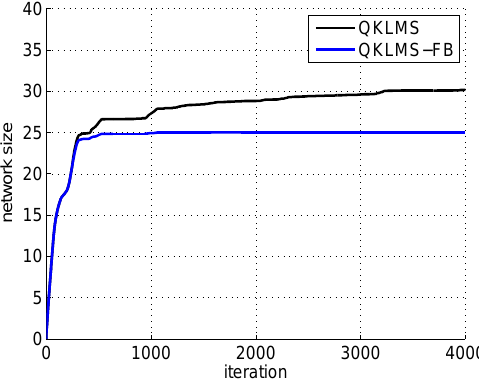
Figure 5. The network size growth curves of the QKLMS and QKLMS-FB algorithms for Lorenz time series prediction.